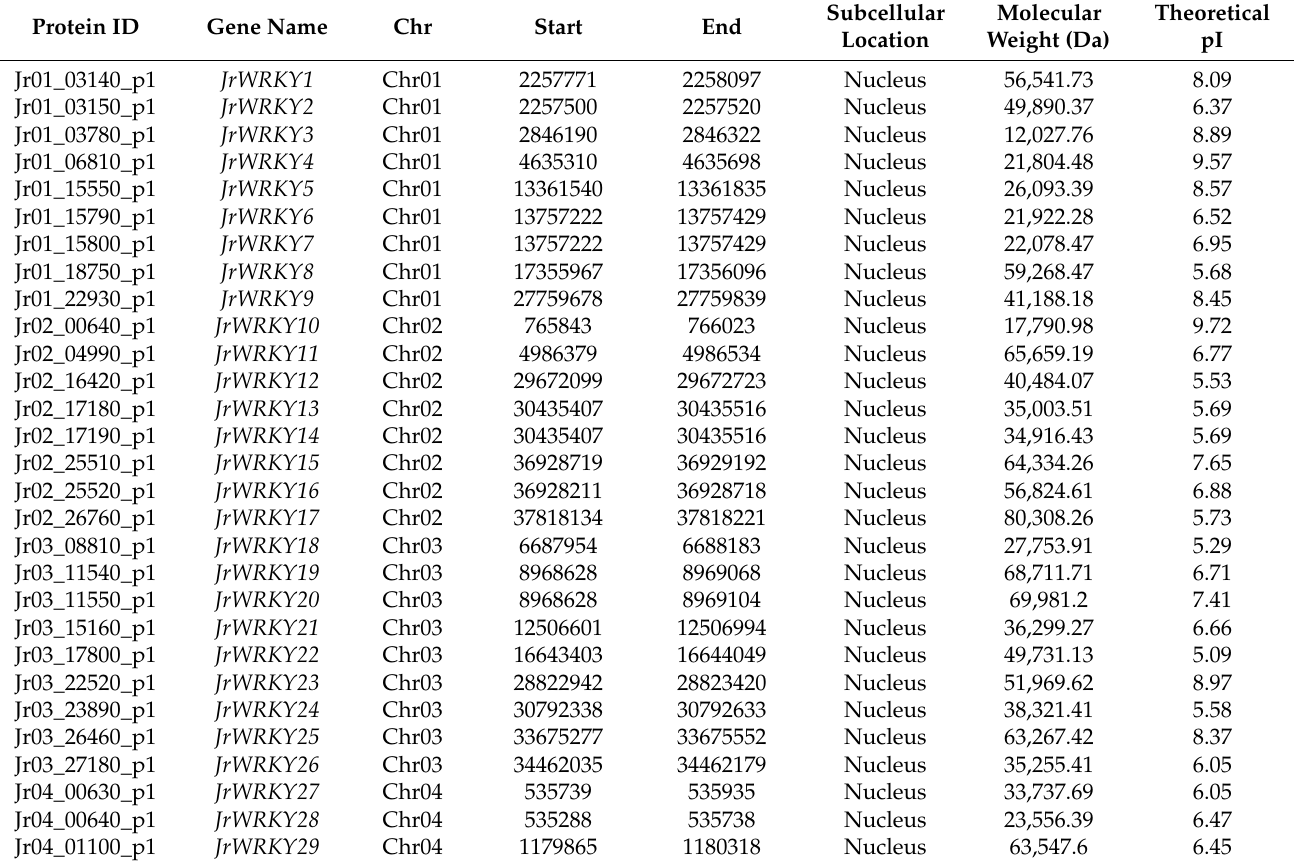
Table 1. Information on the WRKY gene family in common